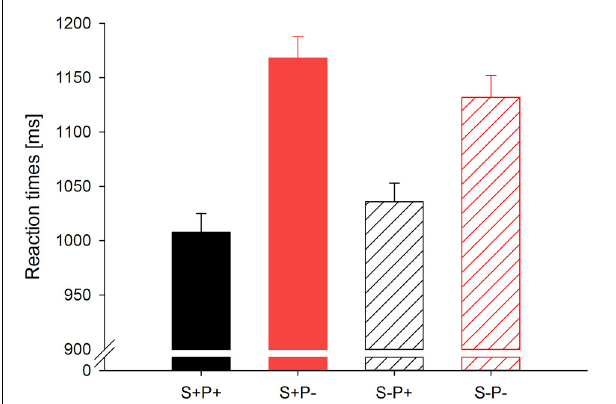
FIGURE 2 | Mean reaction times across all groups for each condition for the first 60 trials (trials without repetition of the target word). Error bars indicate standard errors. The abbreviations of the four conditions are as follows: “S + P + ” for stress match, phoneme match (e.g., MON–MONster ); “S + P − ” for stress match, phoneme mismatch (e.g., TEP–MONster ); “S − P + ” for stress mismatch, phoneme match (e.g., mon–MONster ); and “S − P − ” for stress mismatch, phoneme mismatch (e.g., tep–MONster ). All conditions were significantly different from each